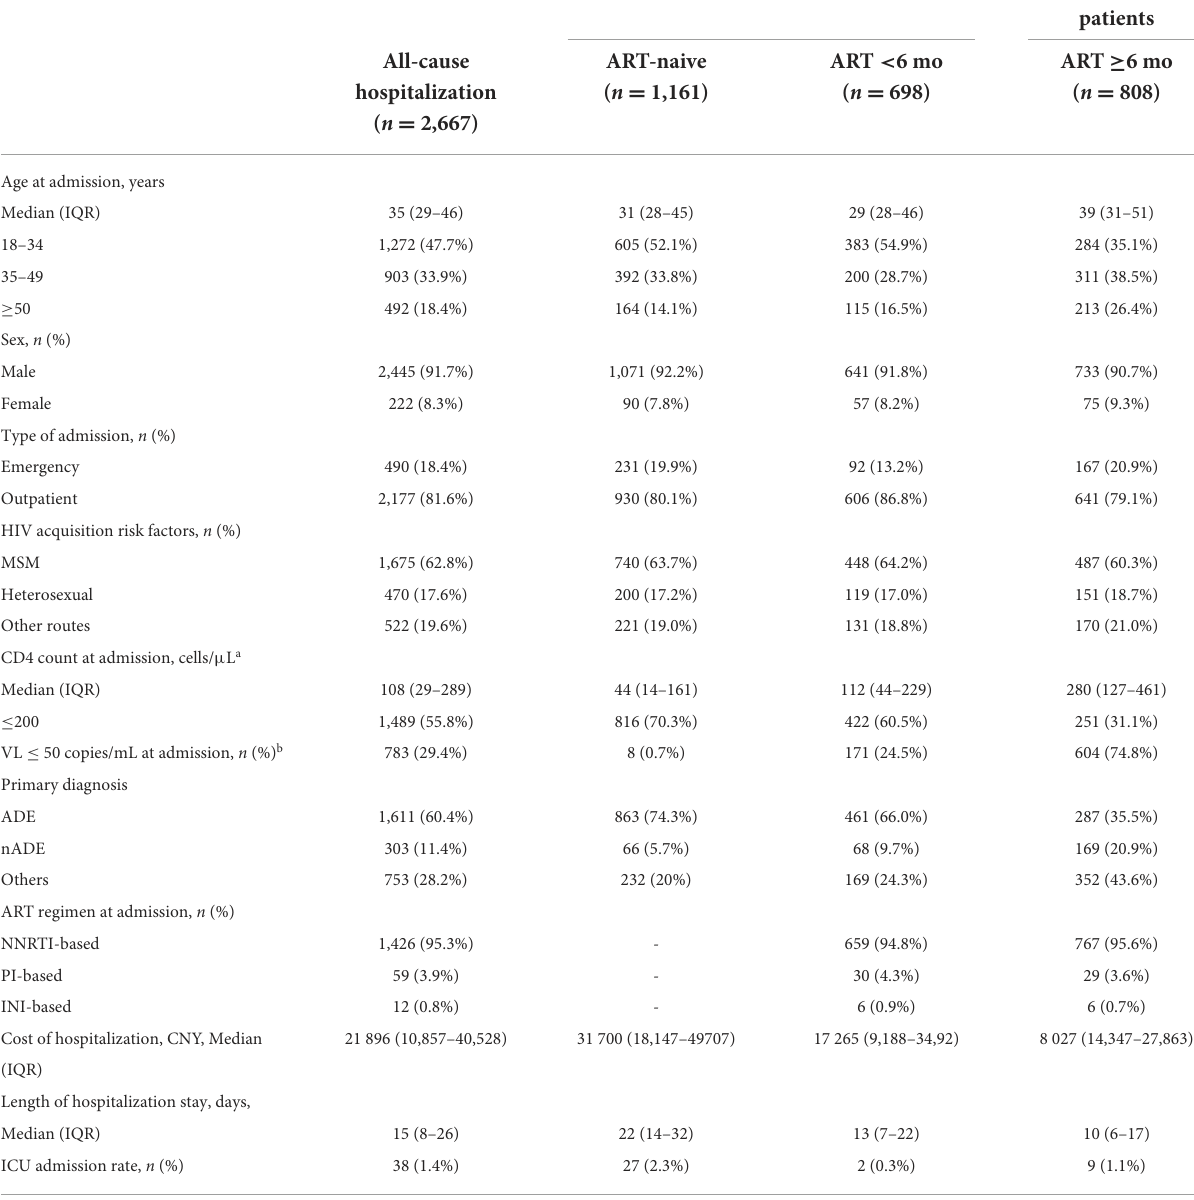
TABLE 2 Demographic and clinical characteristics, overall hospitalization, and ART status of admitted HIV-infected patients in 2008–2020.